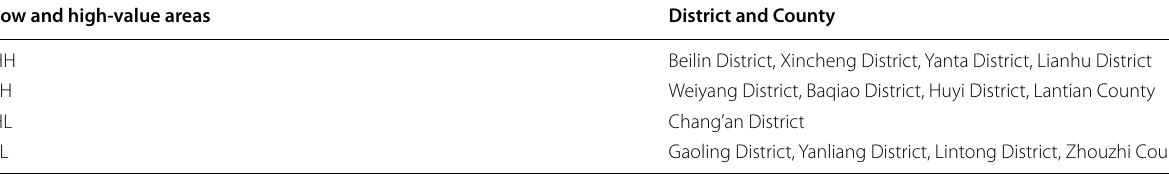
Table 4 Calculation results of low and high value areas of out-of-school hours care places in Xi’an in autumn 2021 Low and high‑value